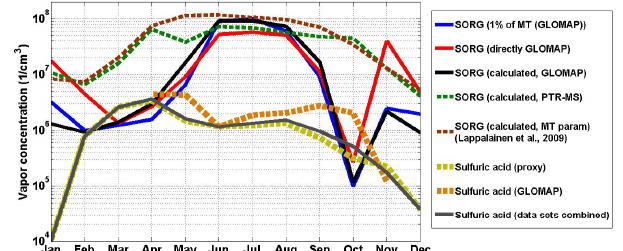
Fig. 2. Monthly median daytime concentrations of SORG MT in Hyyti¨al¨a, Finland, determined five different ways – three of which rely on GLOMAP data (blue, red and black solid lines) and two on measurement data from the PTR-MS (green dashed line), and one from the MT parameterization by Lappalainen et al. (2009) (brown dashed line). For details, see Sect. 2.2.3. Also, the monthly median sulfuric acid concentrations from proxy calculations and from GLOMAP (dashed yellow and orange lines, respectively) as well as their combined data set (solid gray line) are presented (see Sect. 2.2.2 for details).